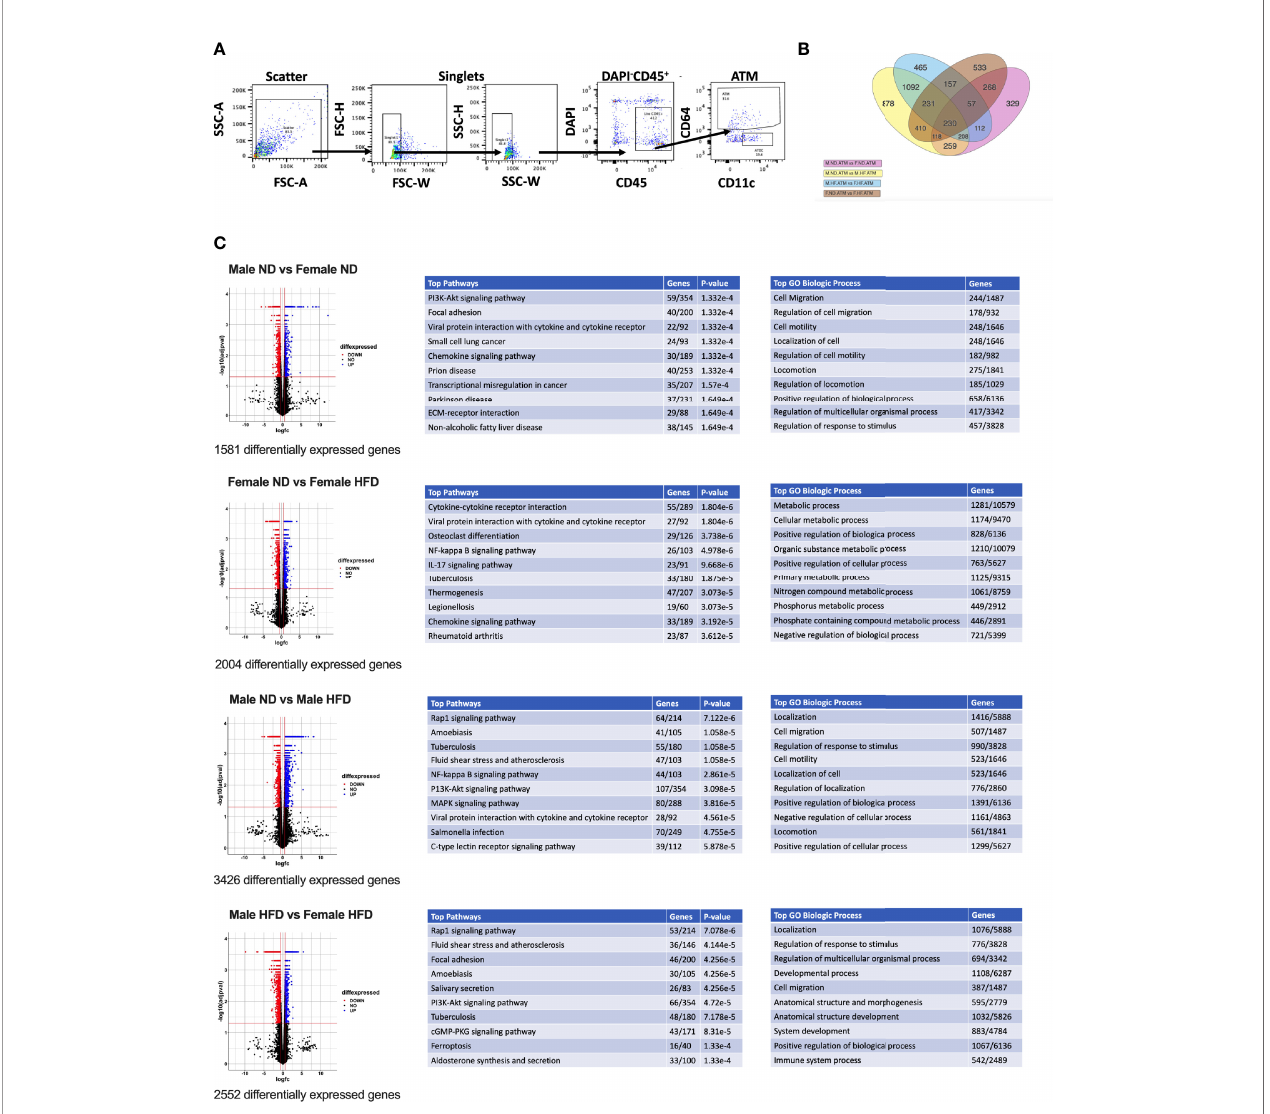
FIGURE 1 | RNA signatures of male and female ATMs. RNA-seq was conducted from (A) FACS sorted male and female ATMs (PI - , CD45 + , CD64 + ) from normal diet (ND) and high fat diet (HFD) for 16 weeks. (B) Venn diagram of the number of signi fi cantly different genes in ATM comparisons of male ND vs male HFD, female ND vs female HFD, male ND vs female ND, and male HFD vs female HFD. (C) Volcano plots of differential genes and top 10 pathways and GO Biologic Process. N = 4 per